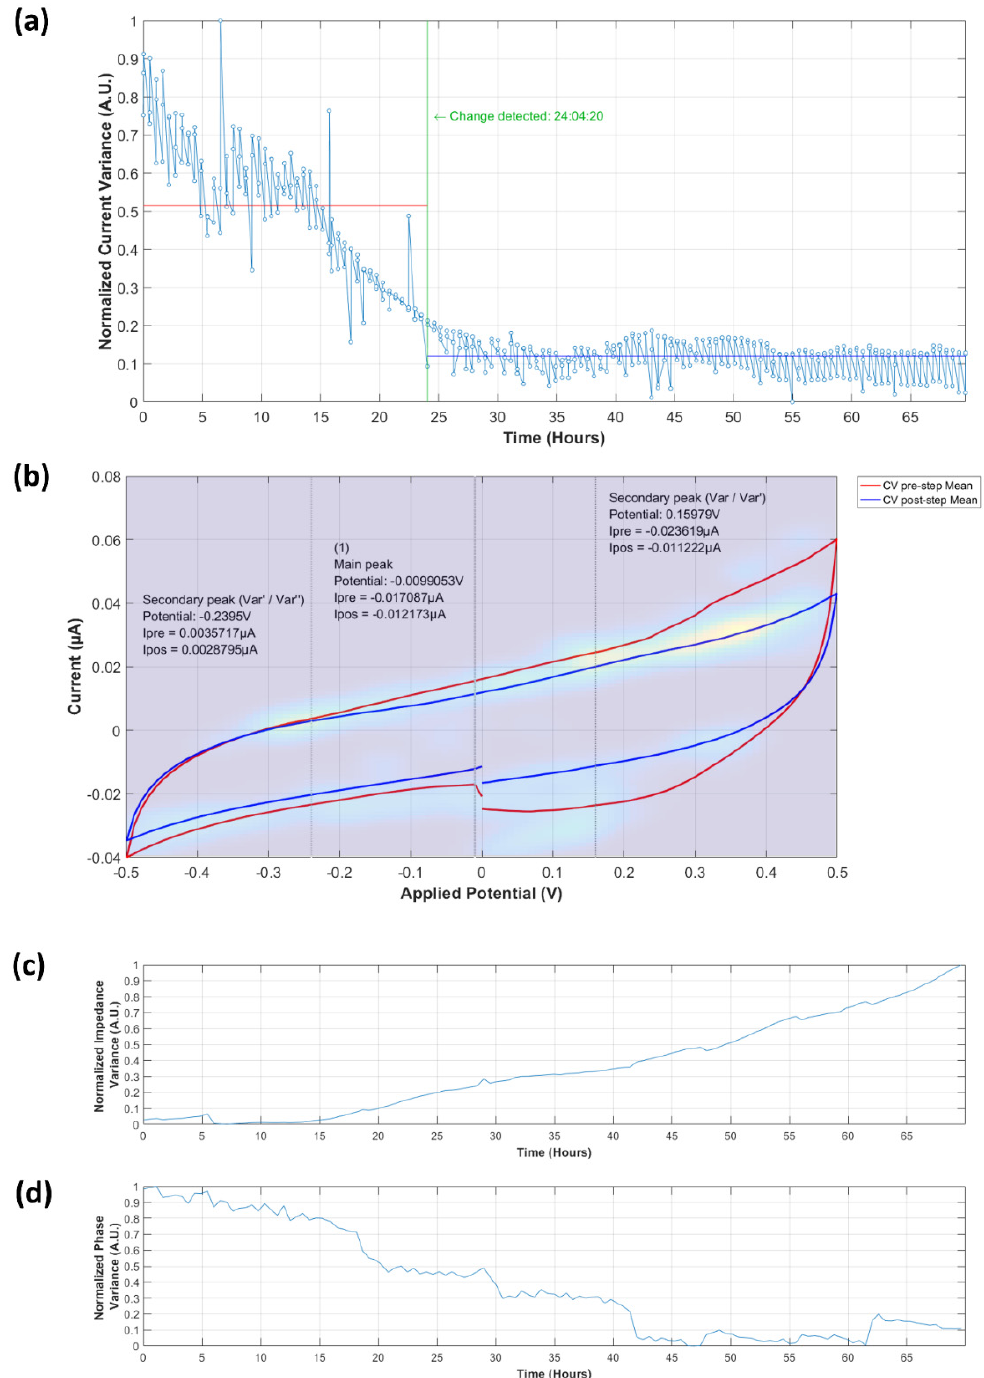
Figure A4. Recorded electrochemical response of a non-colonized microsystem for a ~70 h experiment with no inoculum. ( a ) Normalized current variance vs. time. Detected current peaks are indicated (peaks from variance to its first derivative ratio are indicated as Var/Var’, peaks from first derivative to second derivative ratio are indicated as Var’/Var’’. The current values at each peak are indicated for the mean before colonization event as I pre and for the mean after colonization event as I pos ). Note that the software detected a change, but it does not have the characteristical step shape. ( b ) Recorded CV with calculated peaks and heatmap of detected peaks, where yellow represents a high concentration, and dark blue no peak. ( c ) Normalized impedance variance vs. time. ( d ) Normalized phase variance vs. time.